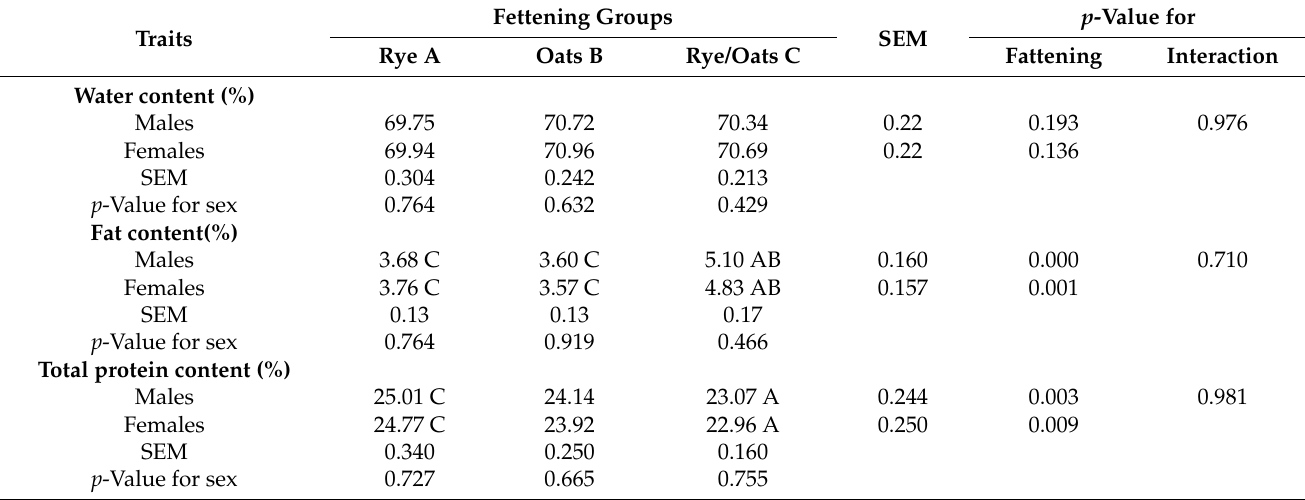
Table 7. Basic chemical composition of the breast